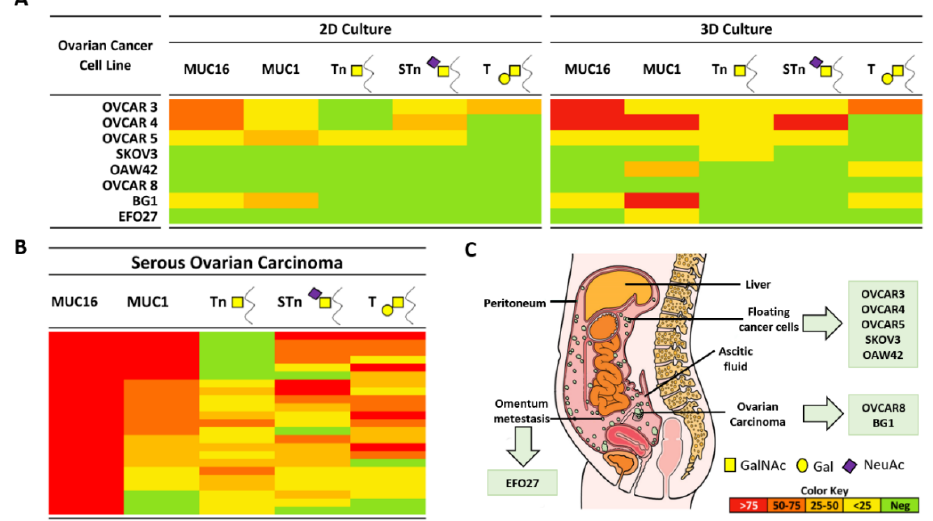
Figure 1. Expression of MUC16, MUC1, and truncated O ‐ glycans in a panel of ovarian cancer cell lines. ( A ) Expression profile of MUC16, MUC1, Tn, STn, and T by immunocytochemistry in eight OVCA cell lines cultured in 2D and 3D conditions; ( B ) Expression pattern of the same mucins and truncated O ‐ glycans in a series of 23 SOCs previously reported by us [10]; the colour key represents the percentage of positive cells for each marker; ( C ) Representation of the origin of ovarian cancer cell lines (adapted from © Macmillan Cancer Support 2018).